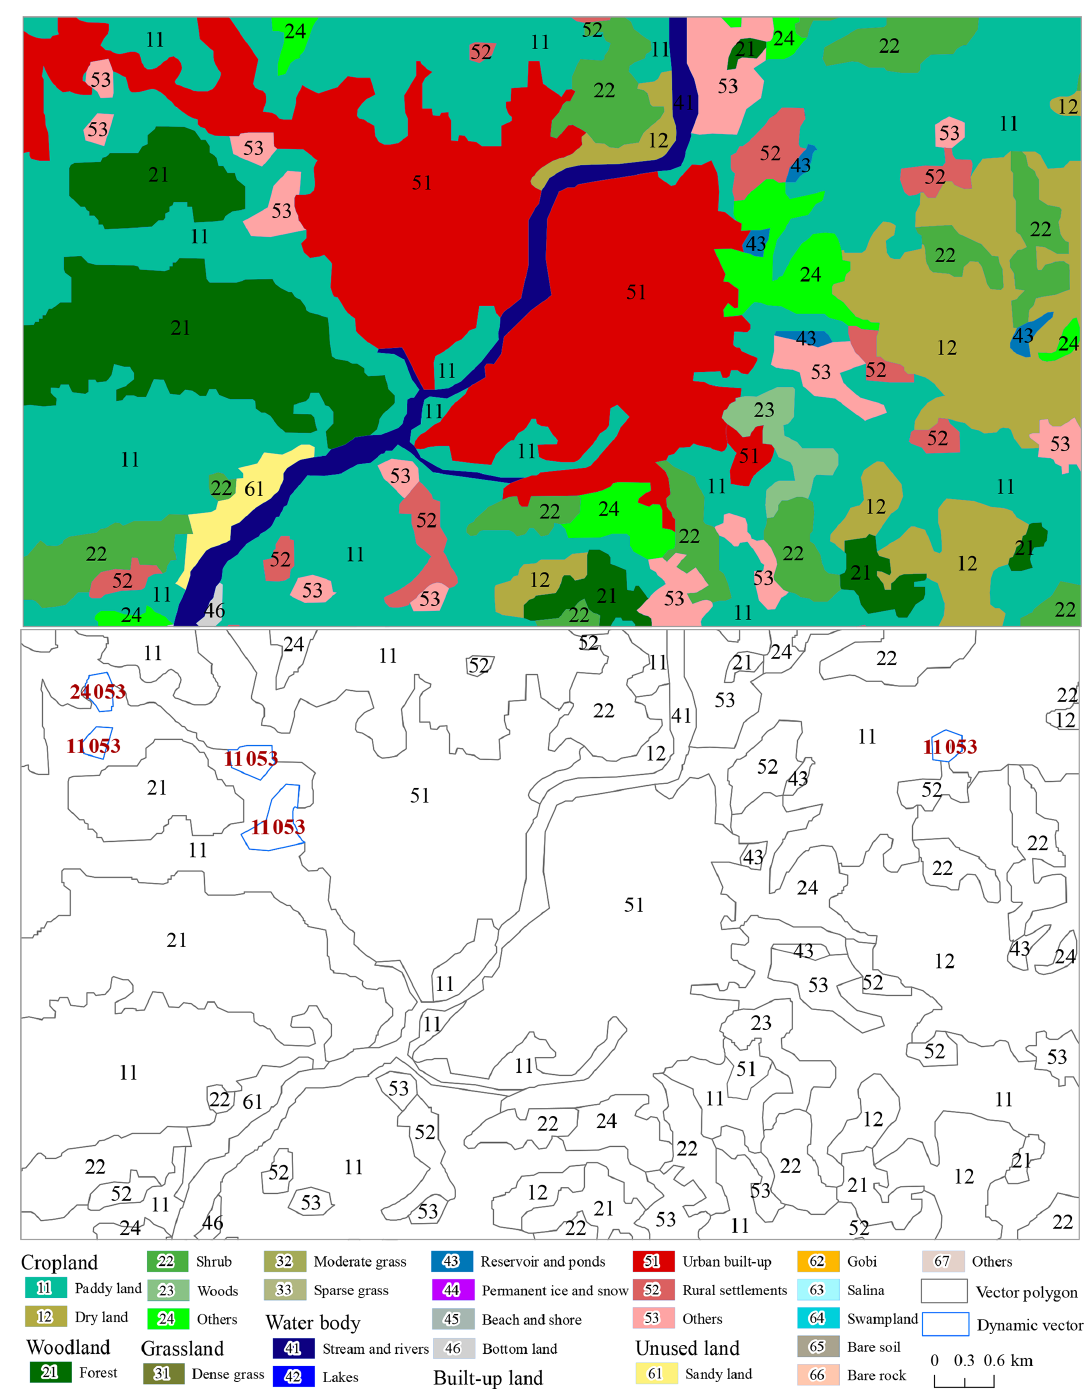
Figure 3. Land use classification and extracted vector polygons as an example with the Conghua district of Guangzhou.